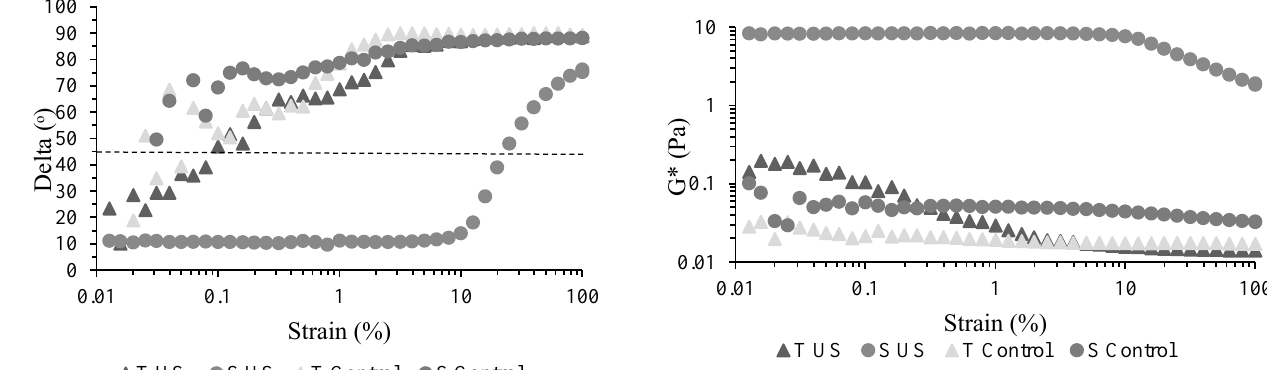
Figure 2. Rheological behavior during small-amplitude oscillatory strain sweep test of the whey protein-thyme EO nanoemulsions. T US—sonicated T nanoemulsion, S US—sonicated S nanoemul- sion, T Control—nanoemulsion, S Control—nanoemulsion.